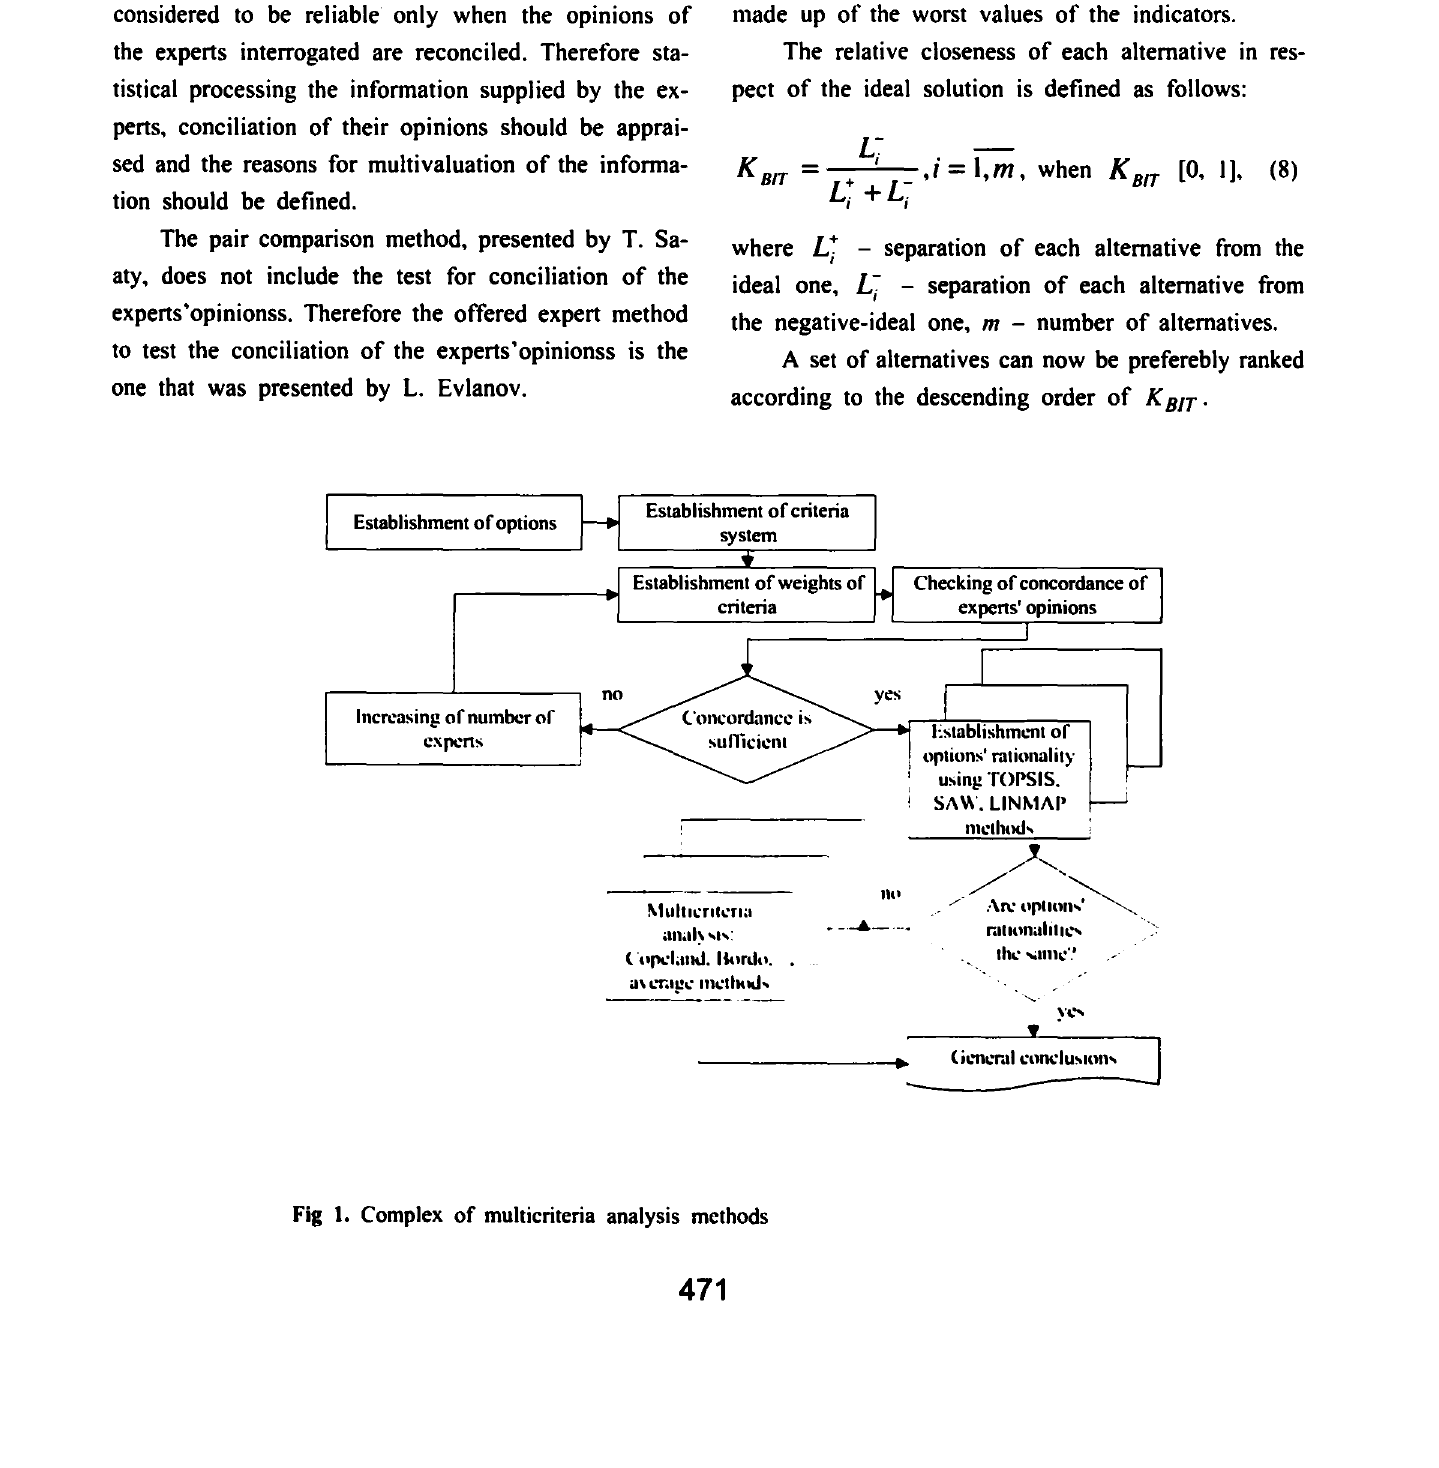
Fig I. Complex of multicriteria analysis